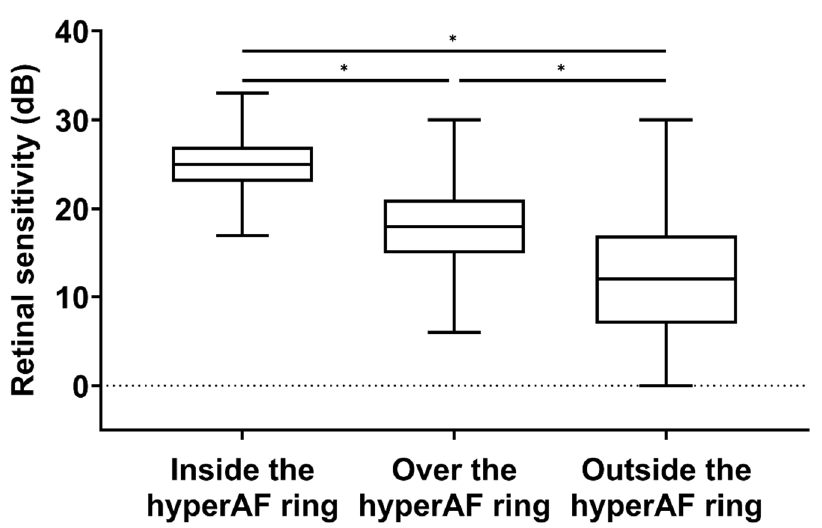
Figure 2. A boxplot comparing retinal sensitivity according to the topographical distribution of testing points regarding the hyperautofluorescent (hyperAF) ring. * p < 0.001. dB = decibels.